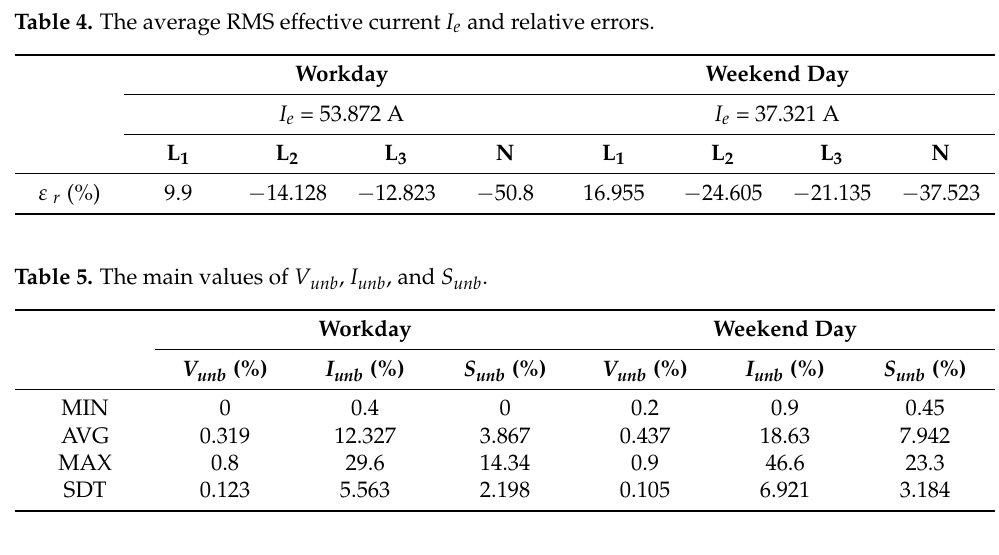
Table 6. The main values of power factors (PF) (-).